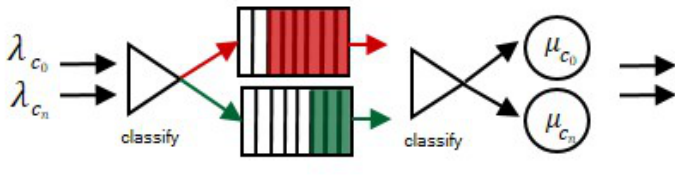
Figure 3. Multiclass and priority